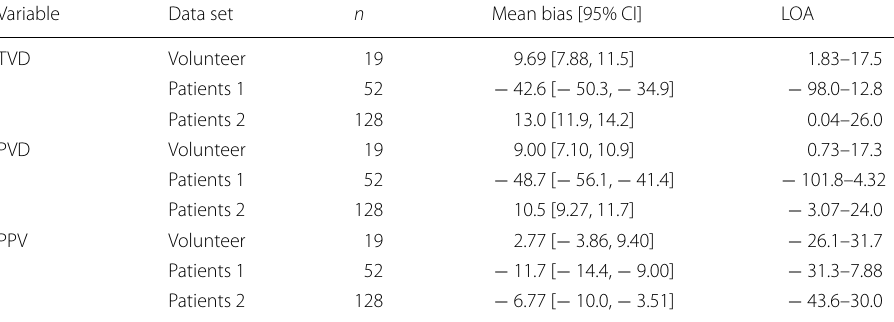
Table 2 Bland–Altman analysis between AVA 3.2 and AVA